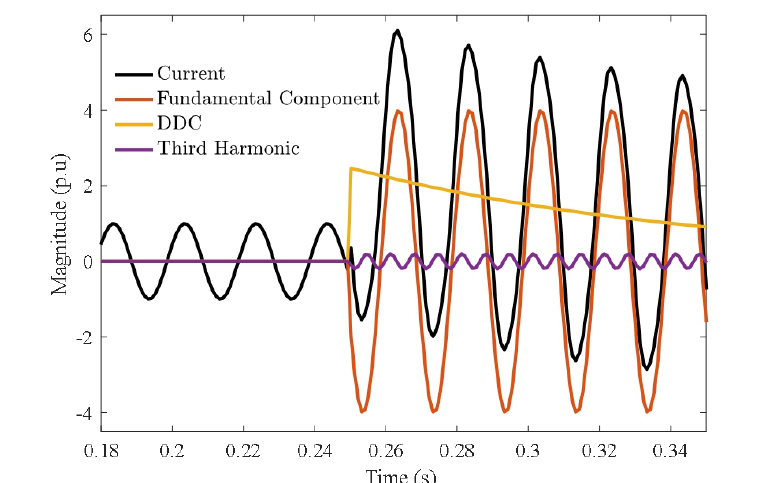
Figure 2. current signal before/after the fault occurs in the presence of DDC and the third